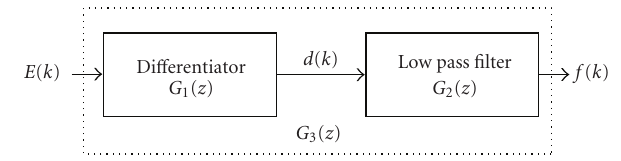
Figure 4: Filters for ECG signal